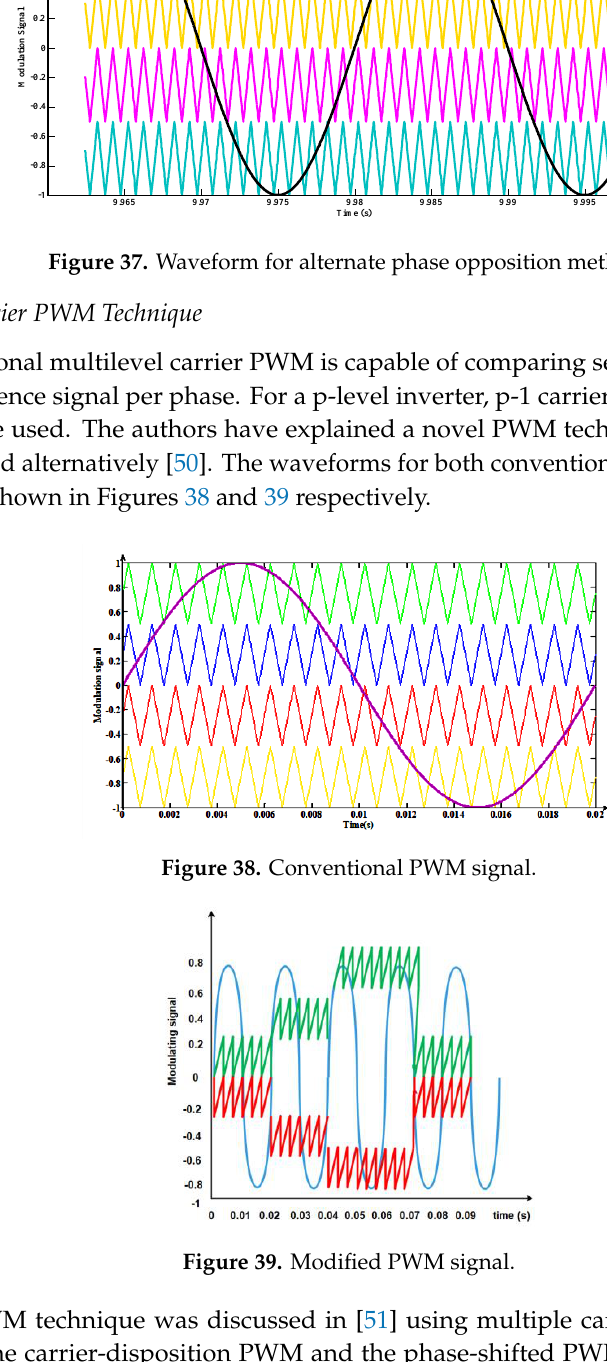
Figure 36. Waveform for phase opposition method.